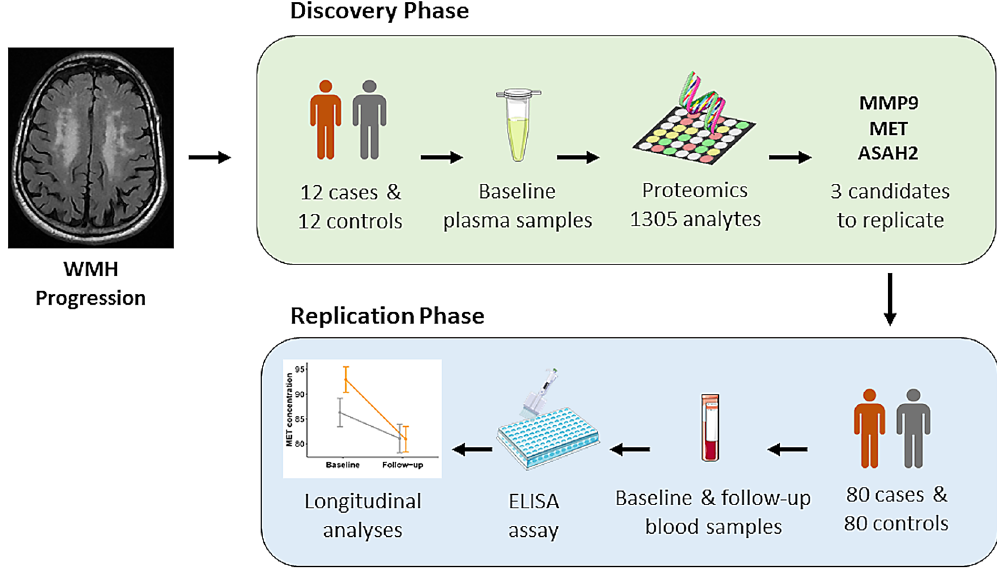
Figure 1. Study design and number of patients in each phase. Discovery and replication phases were conducted within the ISSYS cohort (patients with hypertension, aged 50–70, and without dementia and stroke at the baseline visit). In both phases of the study, progression of WMH was defined as a total RPS score greater than or equal to 3. In the discovery phase, cases and controls were matched by age, sex, and baseline WMH burden, while in the replication phase, cases and controls were matched by age and sex. Parts of this figure were supported by Servier Medical Art (https:// smart. servi er. com/) with permission under the Creative